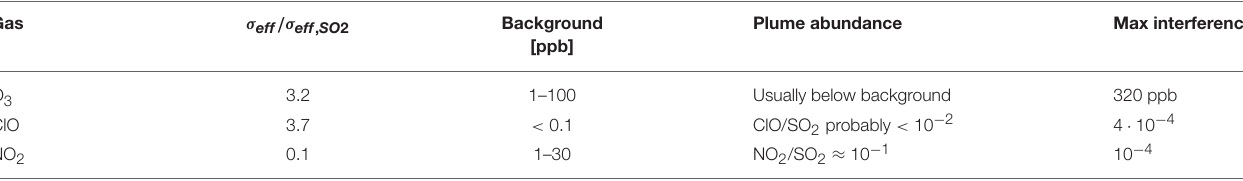
TABLE 2 | The most important cross interfering gas